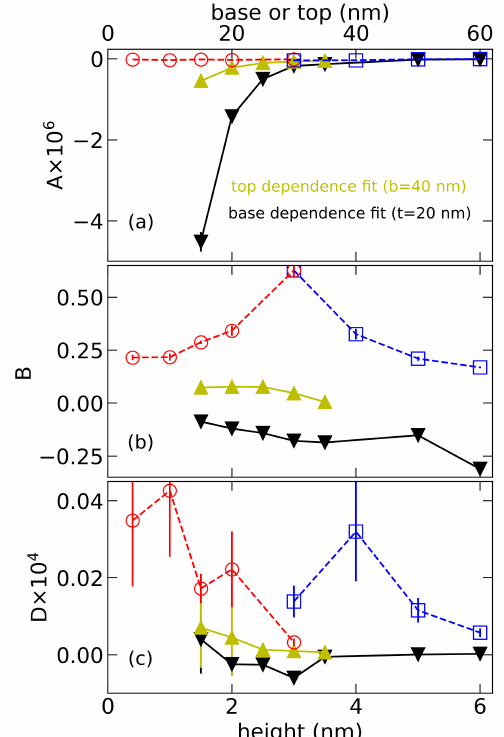
Figure 2. Fitting parameters A [panel ( a )], B [panel ( b )], and D [panel ( c )] from analysis of c QD given in Figure 1 by Equation (4). Parameters A and D are multiplied by factors 10 6 and 10 4 , respectively, for the sake of better visibility. Parameters extracted from fits of the data dependency of c QD on base (top) are plotted here as a function of height with black (yellow) triangles. Similarly, parameters extracted from height dependency are plotted as a function of base (top) diameter in blue